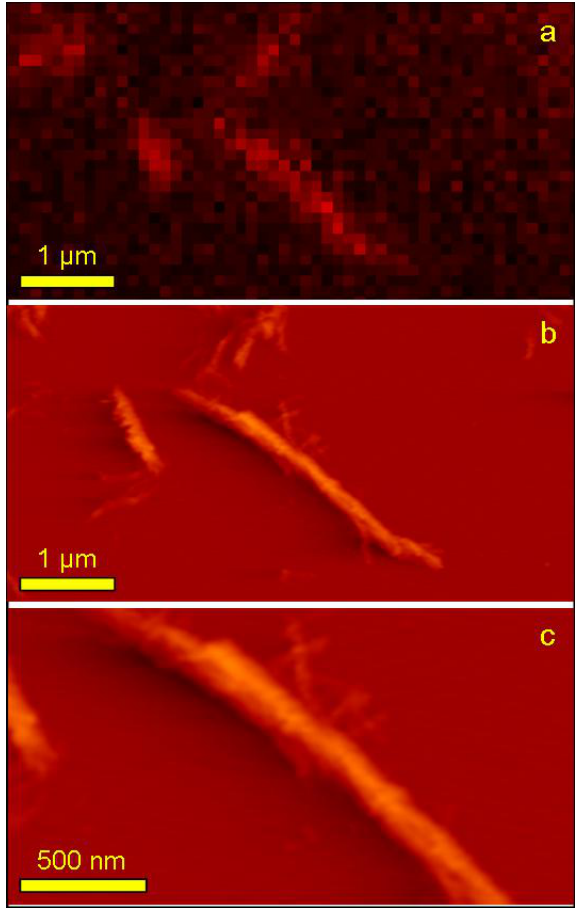
Figure 8. High magnification topographs of insulin amyloids. Zoomed area of TIRFM fluorescence (yellow frame in Figure 7:1a) showing individual small fibrils of insulin: ( a ) fluorescence signal; ( b ) AFM topograph of the same area as ( a ); ( c ) further zoomed area of image ( b ). Deflection error was chosen as representation of AFM topographs due to better